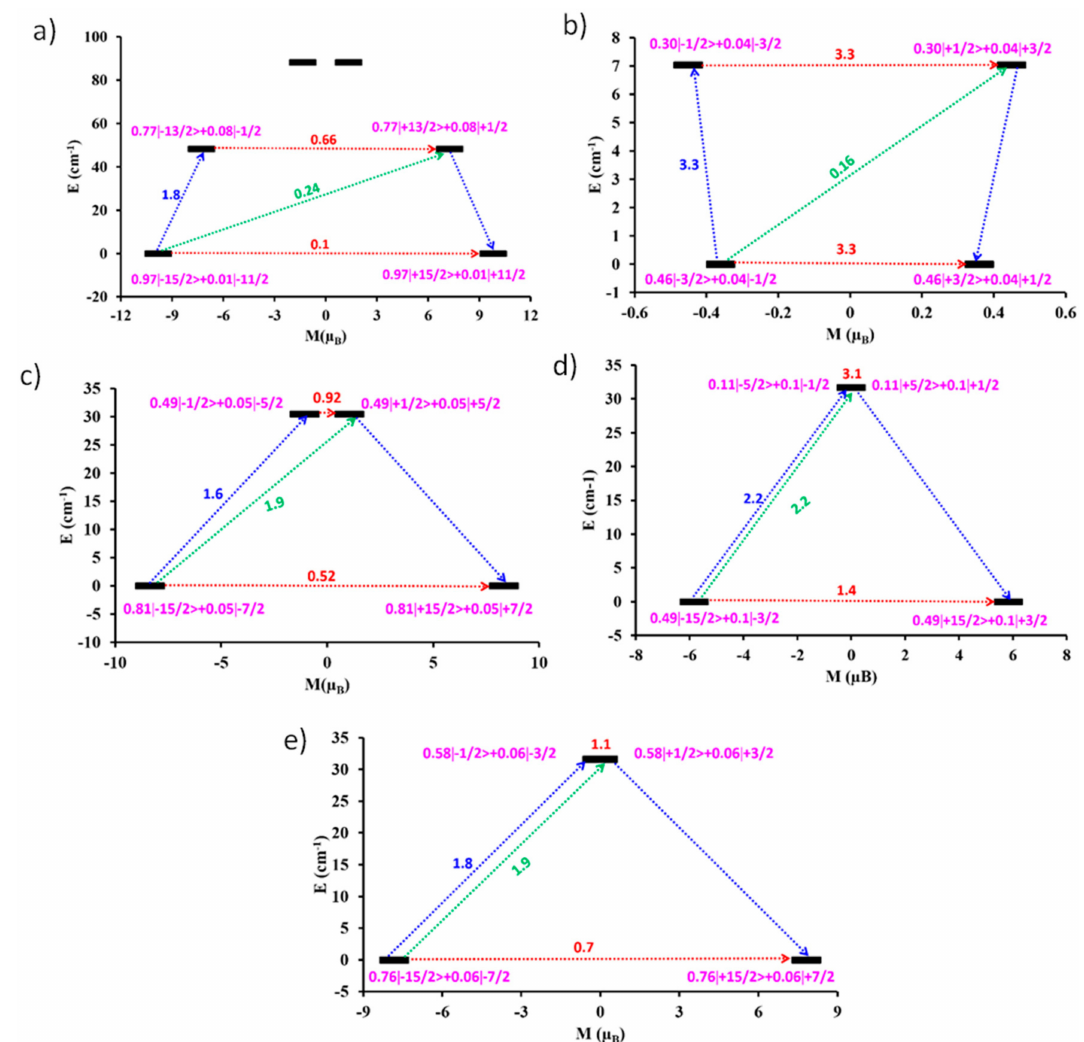
Figure 6. Magnetization blocking barrier for the Dy III site in ( a ) 1 ; ( b ) 2 ; ( c ) 3 ; ( d ) 4 ; and ( e ) 5 . The thick black line indicates the Kramers doublets as a function of computed magnetic moment. The green/blue arrows show the possible pathway through Orbach/Raman relaxation. The dotted red lines represent the presence of QTM/TA-QTM between the connecting pairs. The numbers provided at each arrow are the mean absolute values for the corresponding matrix element of the transition magnetic